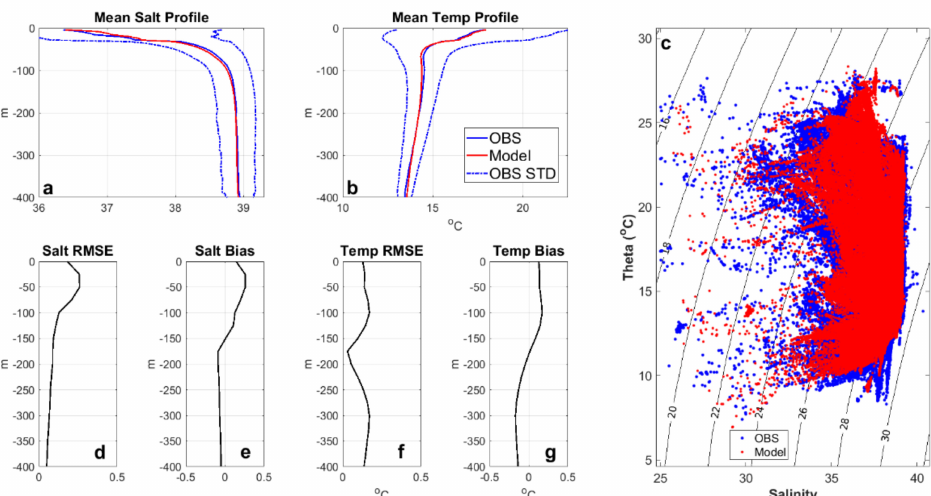
Figure 9. Hydrographic properties at the upper 400 m. Panel ( a ) shows the comparison of the mean salinity profile between observations (blue line) and model’s output (red line). The dashed blue line is the observations standard deviation and defines the confidence interval for the modelled data. Panel ( b ) is the same for potential temperature. Panels ( d – g ) is the error estimation for salinity and temperature in terms of Bias and RMSE, respectively. Panel ( c ) is the θ /S diagram for all profiles from observations and model data for the period from 1986 to